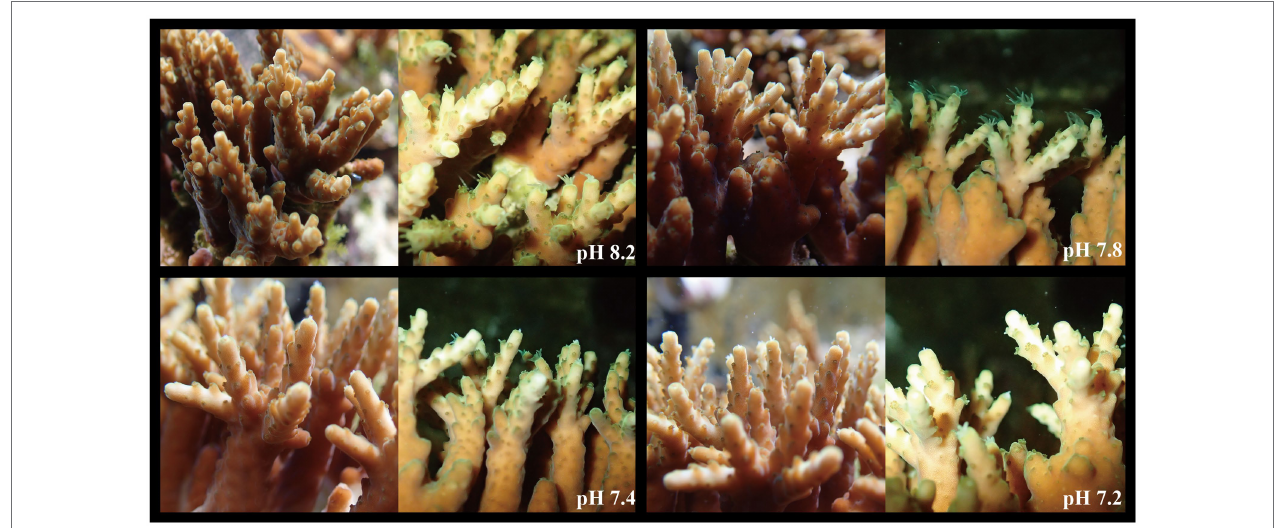
FIGURE 1 | Changes of apparent coral morphology under different pH gradients (two photos for each pH gradient, the left side were taken in simulated daylight, and the right side were taken at night).